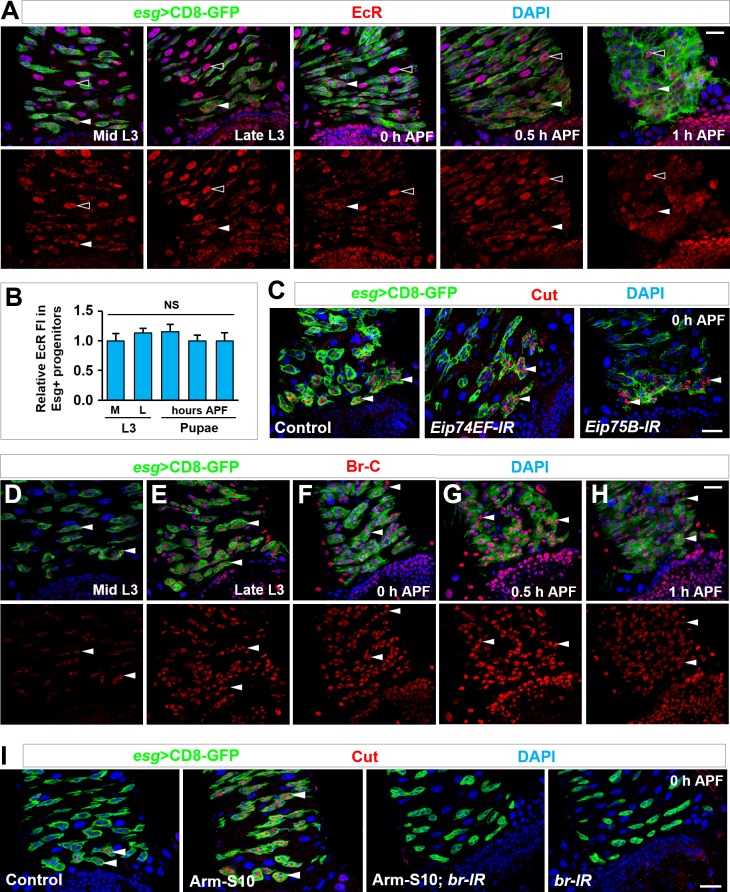
Dynamic expression of Broad, in comparison to EcR, and its epistatic interaction with Armadillo in inducing cut expression.(A,B) EcR is expressed in essentially all cell types in the midgut, including polyploid ECs (open arrowheads) and Esg+ progenitors (closed arrowheads), at similar levels at different developmental stages (A). Quantification of relative EcR fluorescence intensity in Esg+ progenitors is shown in (B). NS, not significant (n = 10). (C) Depletion of ecdysone early response genes Eip74EF or Eip75B in Esg+ progenitors showed no effect on cut induction in future RPs (arrowheads). (D–H) Time-course analysis of dynamic Br-C expression in Esg+ progenitors (arrowheads) at the stages of mid (B) or late (C) third instar larvae, 0 hr (D), 0.5 hr (E) or 1 hr (F) APF. Note that Br-C expression levels in Esg+ progenitors gradually increase (B–D) and reach its peak at around 0.5 hr APF (E), followed by a gradual decline (F). Note that quantification of Br-C expression at different stages is shown in Figure 5B. (I) Ectopic expression of Cut in midgut progenitors (arrowheads), induced by Arm-S10 overexpression, is completely abolished by coexpression of broad-RNAi. Scale bars, 25 μm.